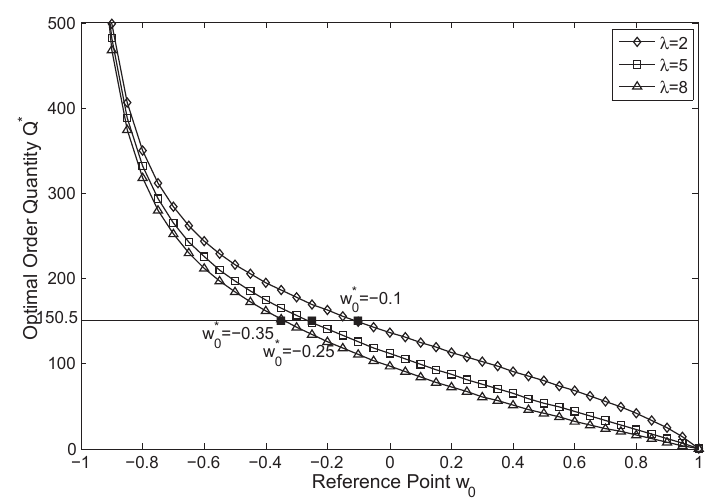
Figure 2. Optimal order quantity vs. reference point for different loss aversion levels.